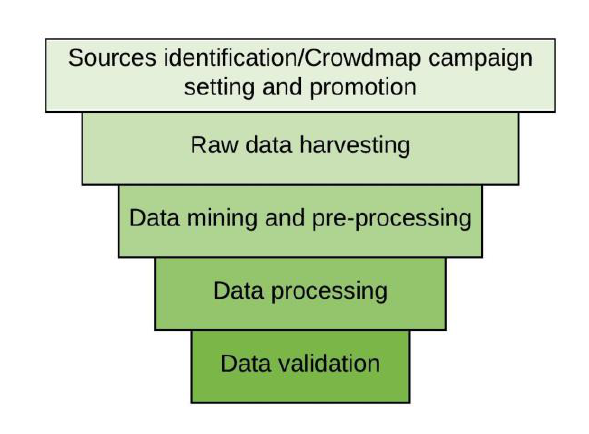
Figure 7. Activity pyramid of combining crowdsourcing